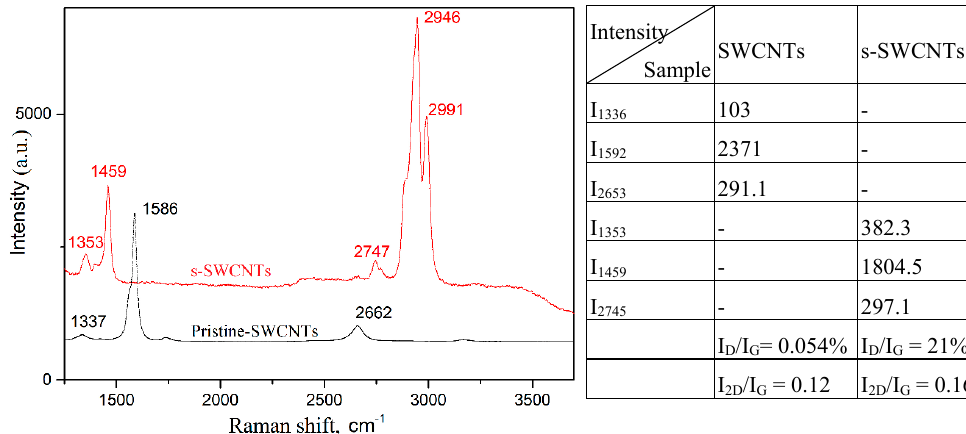
Figure 4. Raman spectra of pristine and sulfonated SWCNTs.